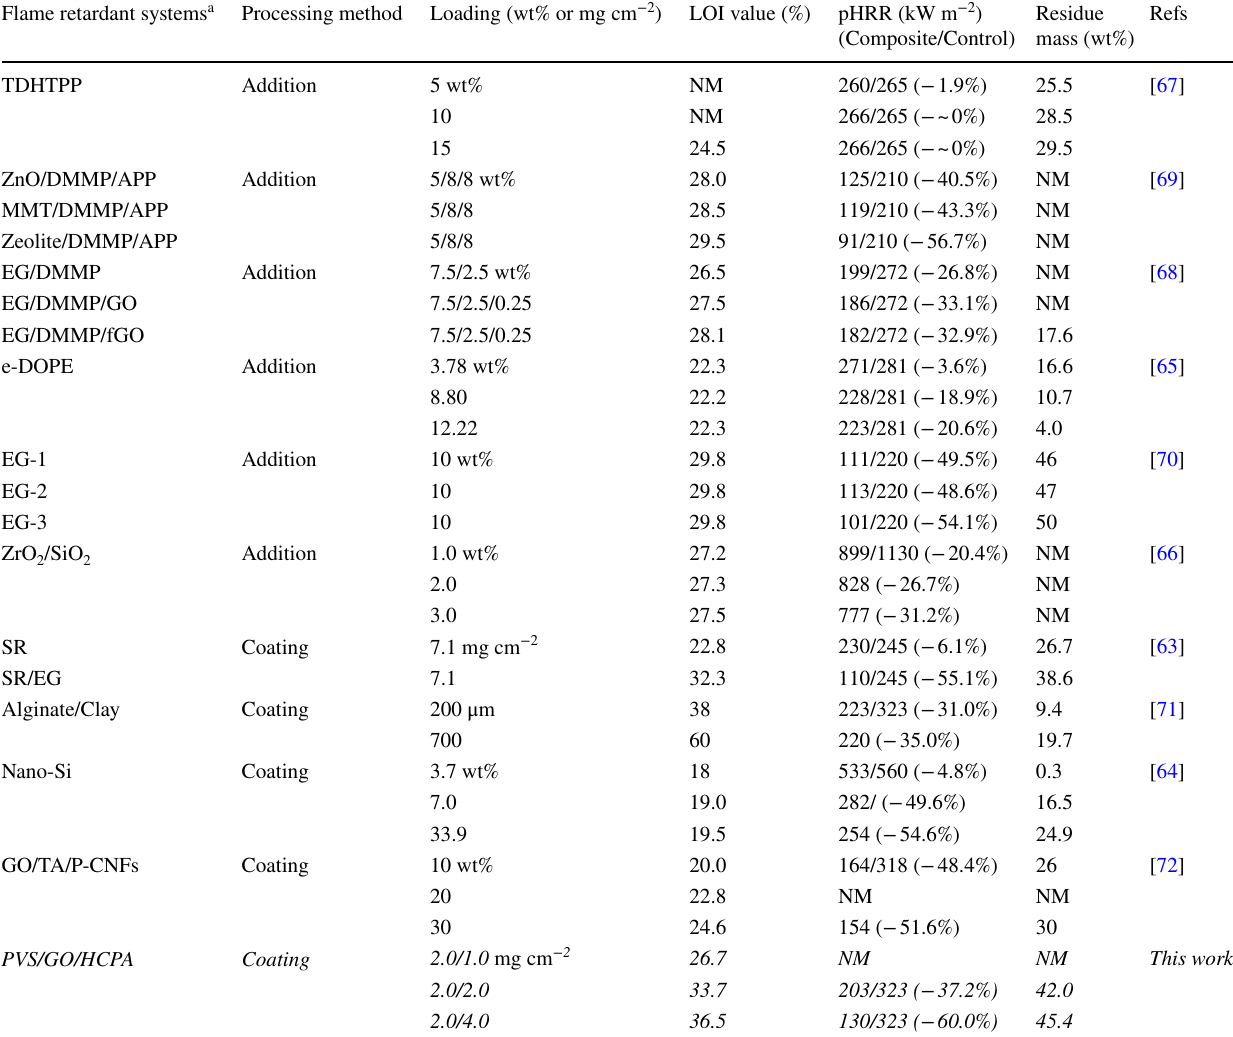
Table 1 Comparison of flame‑retardant performance of our as‑prepared FRPU and other PU foam material